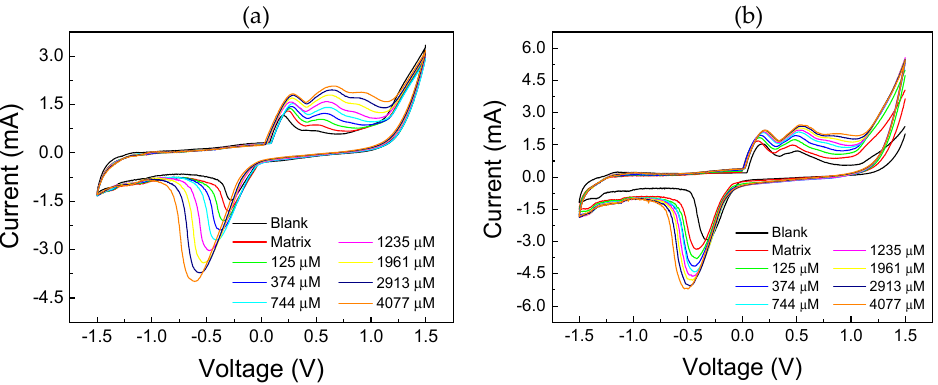
Figure 8. CV curves for the determination of proline content in two different wine samples, ( a ) of red wine and ( b ) of white wine, using the catalytic sensor described in this paper. “Blank” is the CV of the buffer-KCl solution and fixed oxygen peroxide concentration; “Matrix” is the CV after diluted wine sample addition; while other CV curves are those recorded after proline addition, whose final concentration is reported as μ M in the respective legends.